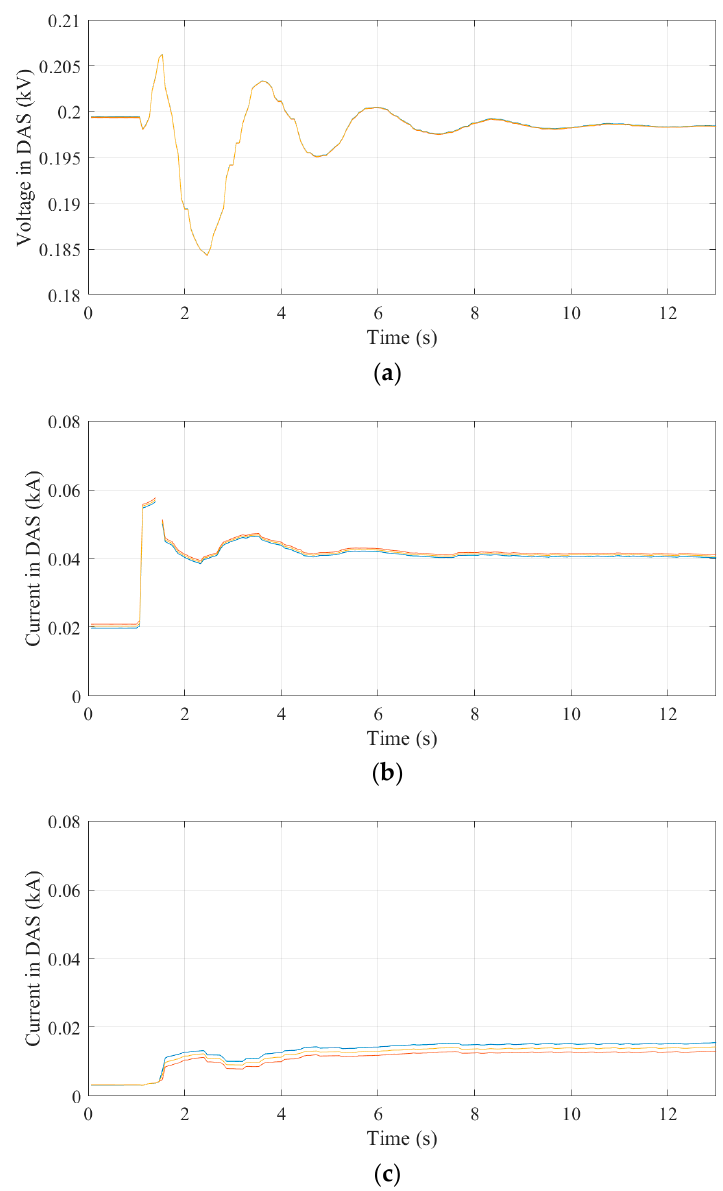
Figure A1. Voltage and current measurements when functions 1 and 2 are activated (load increase from 7 kW to 19 kW): ( a ) line-to-line bus voltages; ( b ) line currents of DG set; ( c ) line currents of BESS.